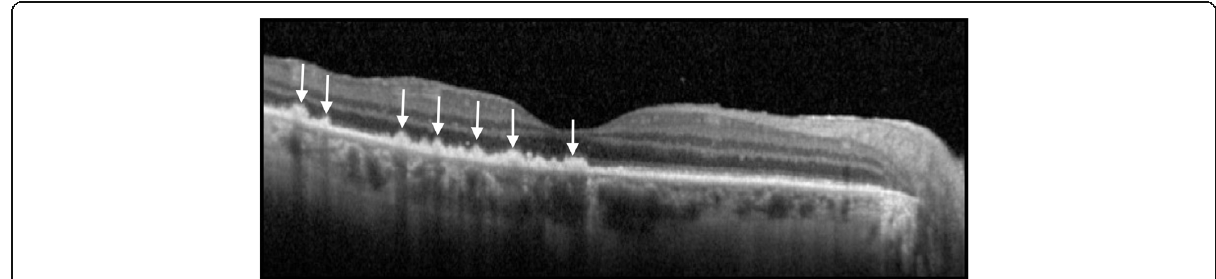
Fig. 6 Spectral domain optical coherence tomography of a tertiary syphilis showing intact external limiting membrane, disrupted ellipsoid zone, thickened and granular hyperreflective RPE, with nodular elevations (white arrows)